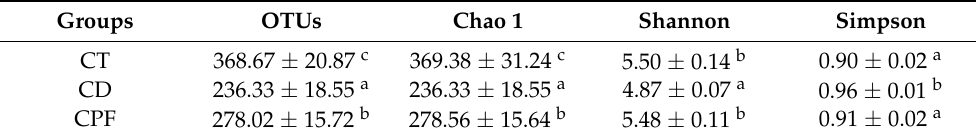
Figure 1. The effect of CPF intervention on intestinal microbiota in mice with circadian rhythm disturbance: ( A ) Venn diagrams of the operational taxonomic unit (OTU) in the three groups. ( B ) Circos plot of the top5 microbial taxa at the phylum level. Microbial distributions of differ- ent groups at the phylum ( C ) and genus levels ( D ). Difference analysis of gut microbiota composition at the genus level between the CD and CT groups ( E ) and between the CD and CPF groups ( F ). ( G ) Dominant microbial taxa of the CPF group. ( H ) The alternation of the microbial taxa in the CD group. ( I ) The alternation of the microbial taxa in the CPF group. Table 1. The α -diversity of gut microbiota among the three